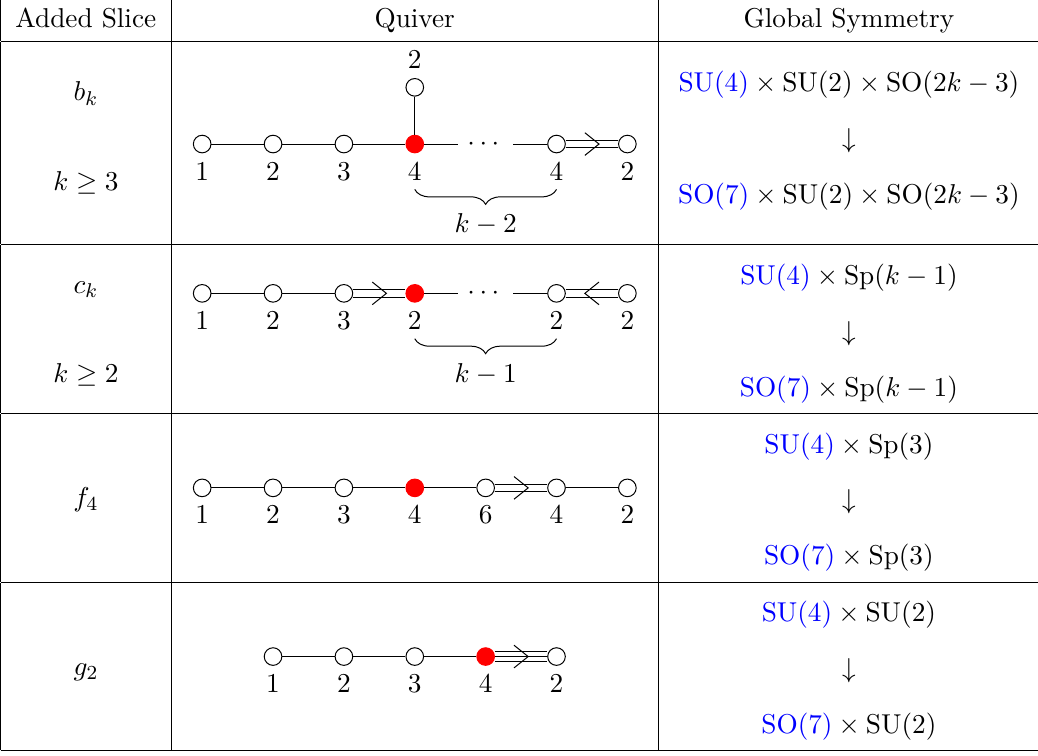
Table 6 . Quivers resulting from adding the possible non-simply laced elementary slices to n.min B 3 (4.5) to absorb a